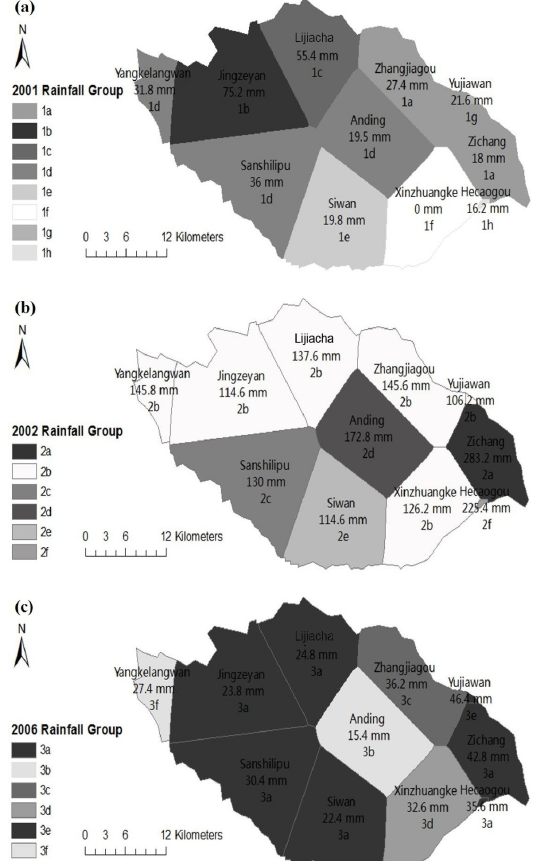
Figure 4. Classification results of rainfall stations of three typical events in the upstream of the Qingjian River basin: ( a ) 2001, ( b ) 2002 and ( c ) 2006. Classification using clustering based on the total depths and correlation methods based on the processes of rainfall measurements are conducted.